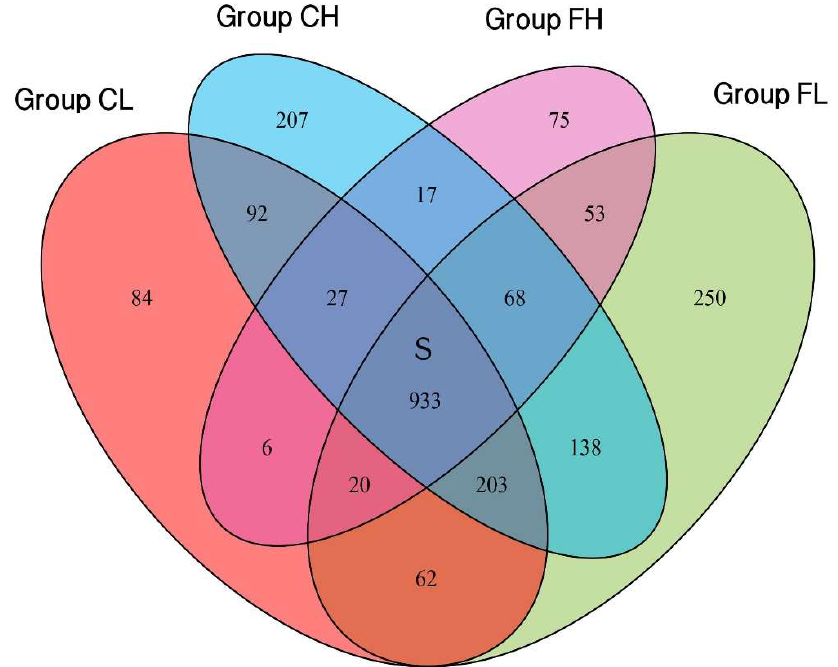
Figure 3. Venn diagram at species level.